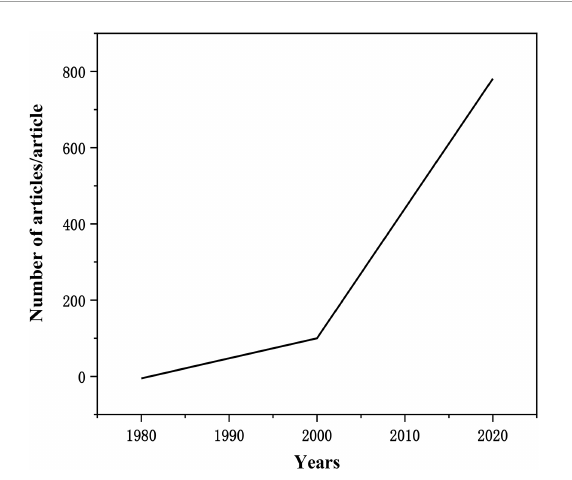
FIGURE3 Number of papers published in the field of Marine ecological restoration from 1982 to 2021.